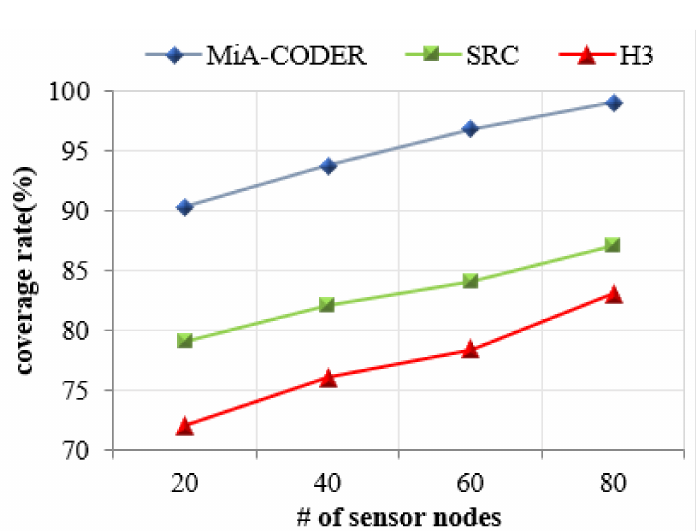
Figure 5. Number of sensor nodes vs. coverage